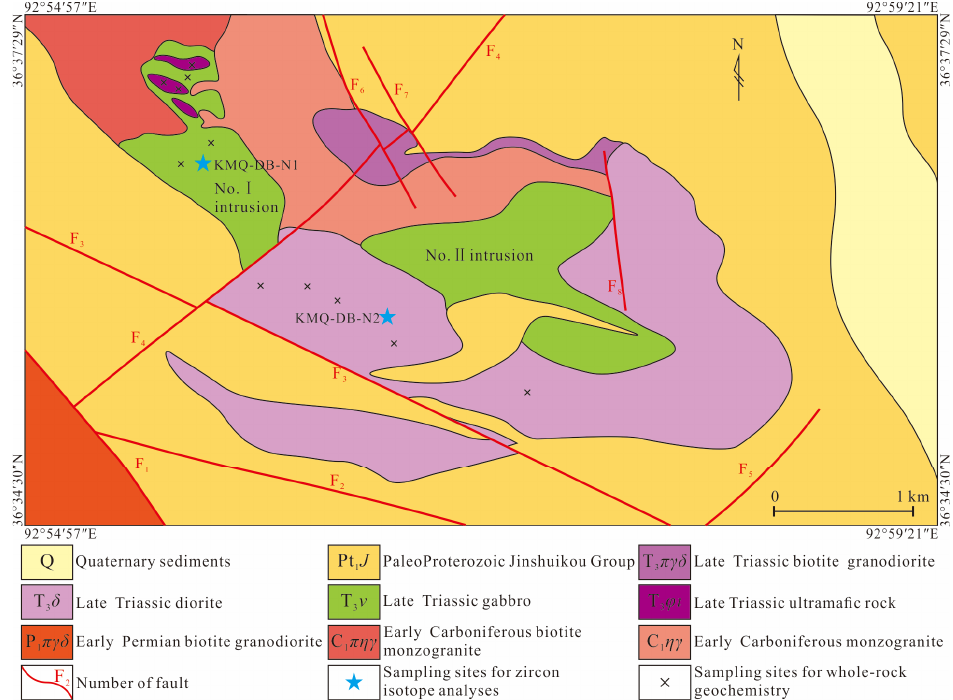
Figure 2. Geological map of the Kaimuqi area (modified after [38]).